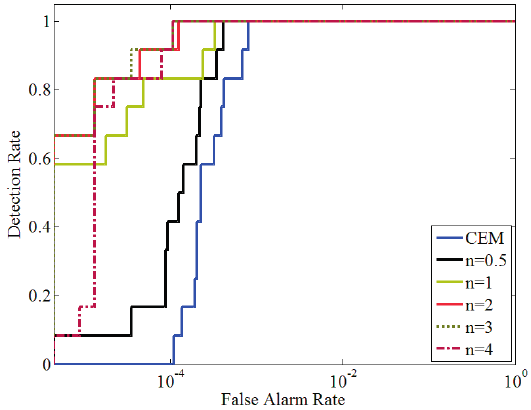
Figure 4. ROC curves corresponding to the detection results reported in Figure 3. Table 1. Computing time of five algorithms in the detection of the HyMap real data.